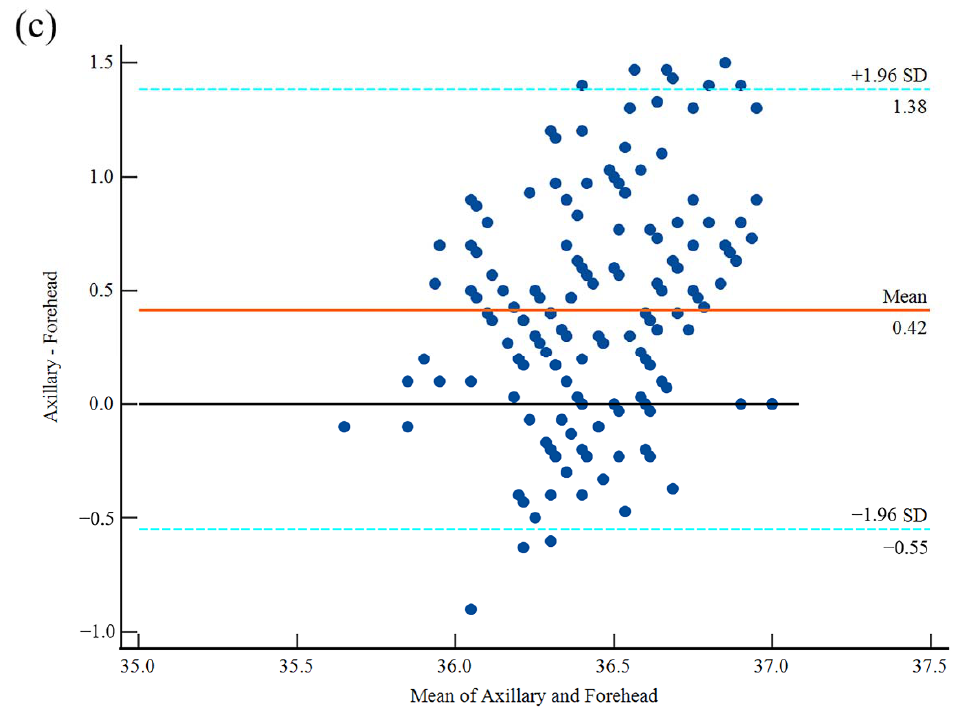
Figure 3. Bland–Altman plot with the mean difference and 95% limits of agreement; ( a ) the axillary and oral temperature data, ( b ) the oral temperature and forehead temperature data, ( c ) the axillary temperature and forehead temperature data.